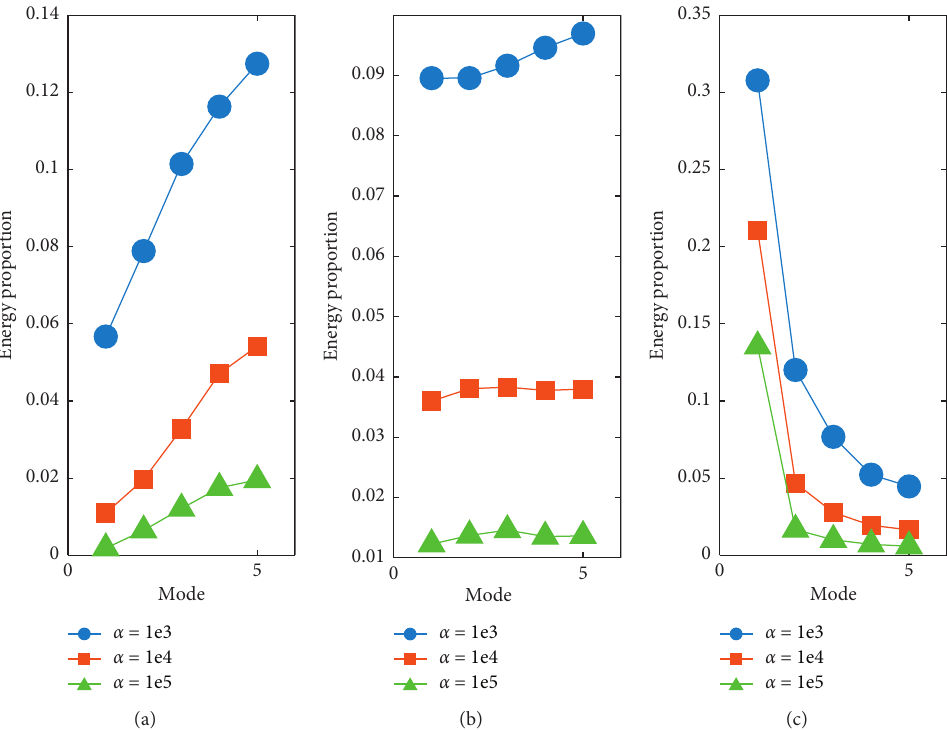
Figure 4: The averaged energy proportion of each mode u k plotted as a function of modal order, in the case of three typical Hurst exponents: (a) H � 0.2, (b) H � 0.5, and (c) H � 0.8.